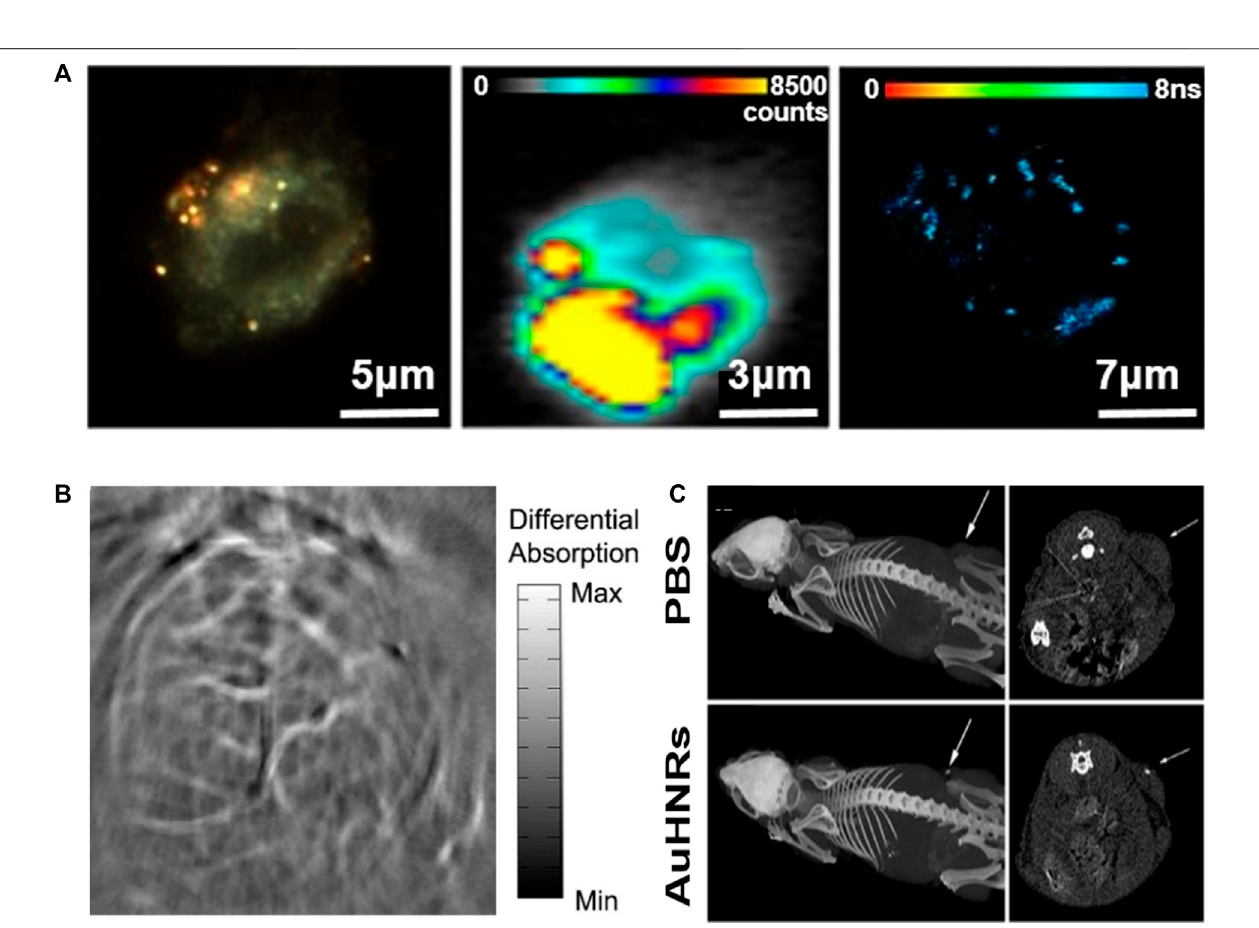
FIGURE 10 | Schematic illustration showing drug/gold nanocage (AuNC)-loaded dissolving hyaluronic acid microneedle (HA MN) system for the combined chemotherapyandPTTofmelanoma. (E) Confocallaserscanningmicroscope(CLSM)image,bright- fi elddermoscopyimage,andmerged image.Thered fl uorescence signal in the CLSM image indicated the penetration of AuNCs in the skin indicated, whereas the black dots in the bright- fi eld image indicated the MN insertion sites. (F) Tumorvolumeofeachgroupwithincreasingtimefor12days (A,B,C) ReprintedwithpermissionfromSunetal.(2017).Copyright2016,WILEY-VCHVerlagGmbHand Co. KGaA, Weinheim. (D, E, F) Reprinted with permission from Dong et al. (2018). Copyright 2018, American Chemical Society.